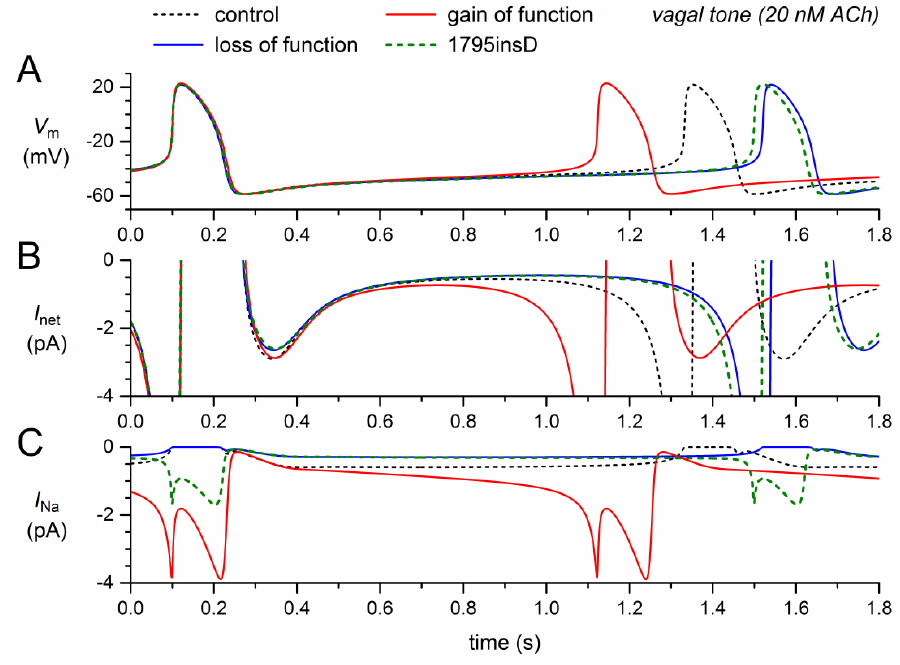
Figure 5. Changes in the electrical activity of the Fabbri – Severi model cell at low beating rate (vagal